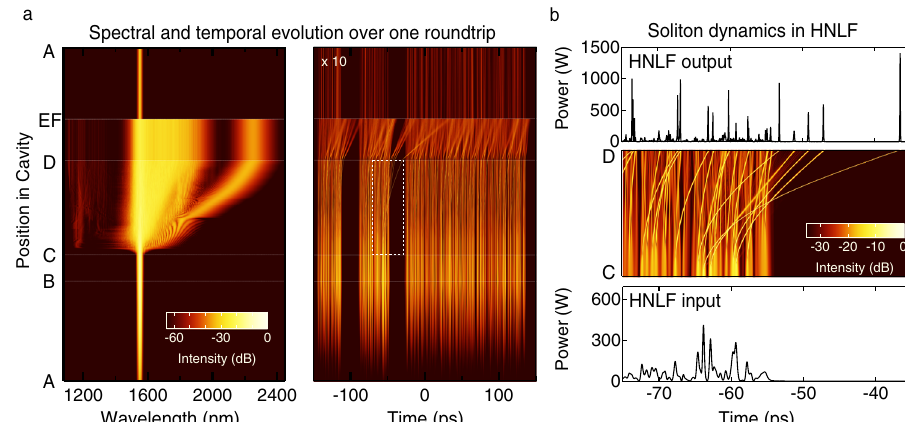
Fig. 2 Typical results from numerical simulations showing the evolution over one roundtrip in the noise-like pulse regime. a False-colour evolution plots in (left) spectral and (right) temporal domains to illustrate the dramatic differences in evolution in the different cavity segments. The labels A – F refer to the cavity schematic in Fig. 1. Because of the signi fi cant loss due to the spectral fi lter in the bulk segment, the temporal intensity in segment FA is scaled by a factor of 10×. b The HNLF evolution in segment C, D over an expanded 40 ps time window to clearly reveal the soliton dynamics and Raman soliton evolution. This is the region indicated by the dashed white lines in a . This fi gure also shows the intensity pro fi les at the input and output of the HNLF.